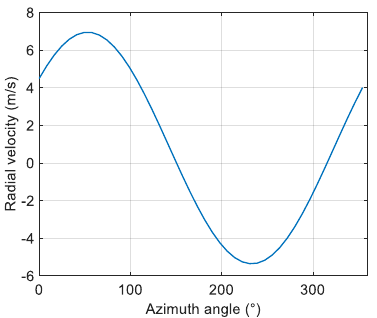
Figure 3. The variation of radial velocity of spaceborne radar with azimuth in uniform wind field.